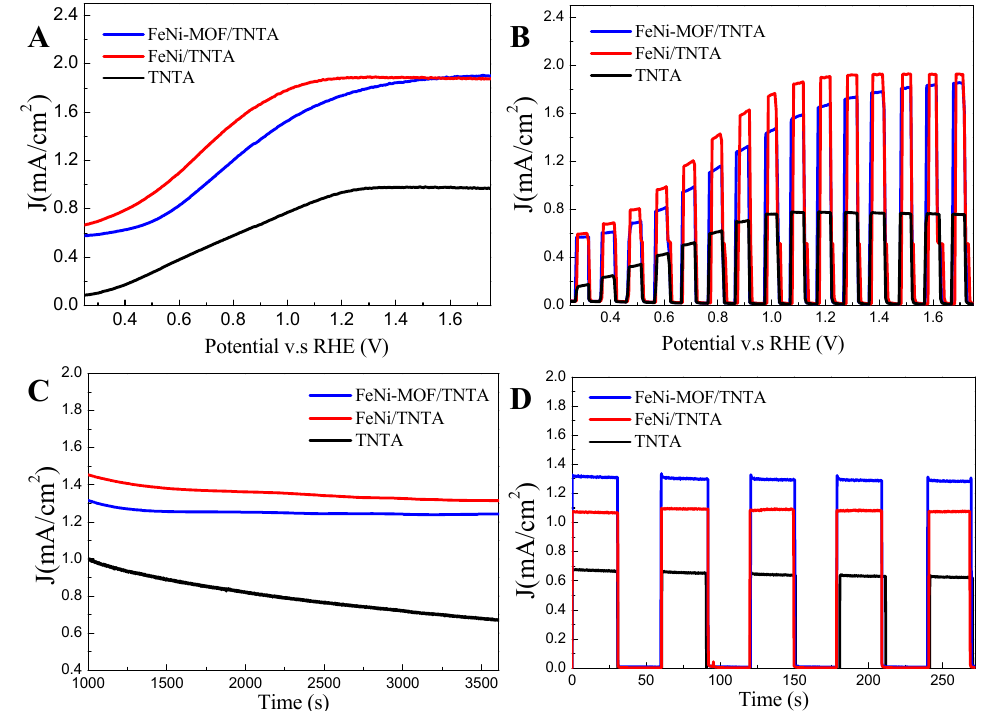
Figure 6. ( A ) LSV curves of optimization for TNTA, FeNi / TNTA, and FeNi-MOF / TNTA at 10 mV; ( B ) The chopped light chronoamperometric measurements of optimization for TNTA, FeNi / TNTA, and FeNi-MOF / TNTA at 10 mV; ( C ) The stability measurement of TNTA, FeNi / TNTA, and FeNi-MOF / TNTA at 1.0 V for 1 h; ( D ) The chopped light chronoamperometric measurements of optimization for TNTA, FeNi / TNTA, and FeNi-MOF / TNTA at 1.0 V after 2